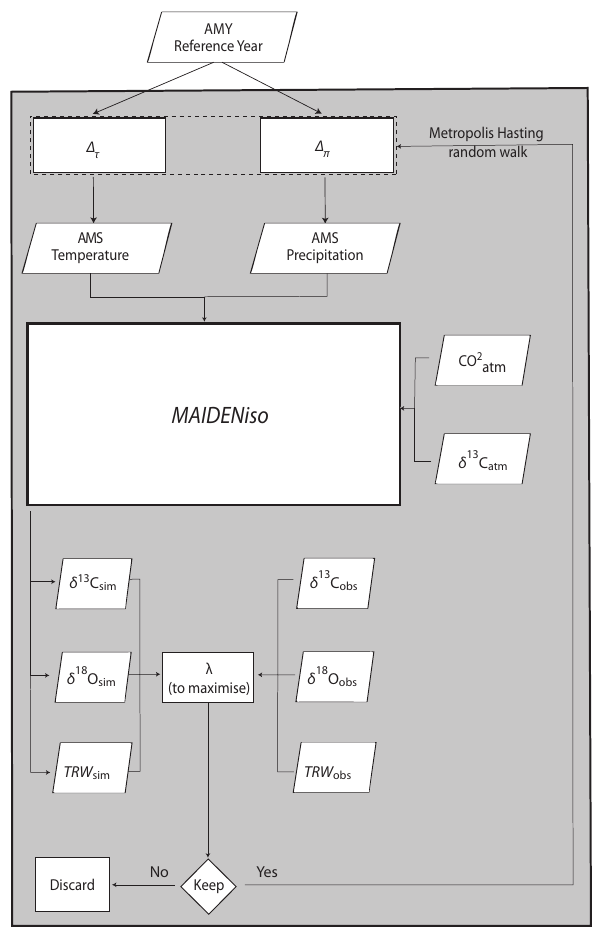
Figure 1. MAIDENiso’s inversion flowchart. For each year simu- lated, two 1 modify the AMY: one for temperature ( δ τt ) and one for precipitation ( δ πt ). The resulting AMS is passed to MAIDENiso, along with atmospheric CO 2 concentrations and atmospheric δ 13 C to simulate tree growth parameters. Simulated tree growth is com- pared to observations, through the metric λ , which has to be maxi- mized (Eq. 1). The Metropolis–Hastings algorithm iteratively mod- ifies the value of δ τ and δ π so that it converges towards stable states (Eq.